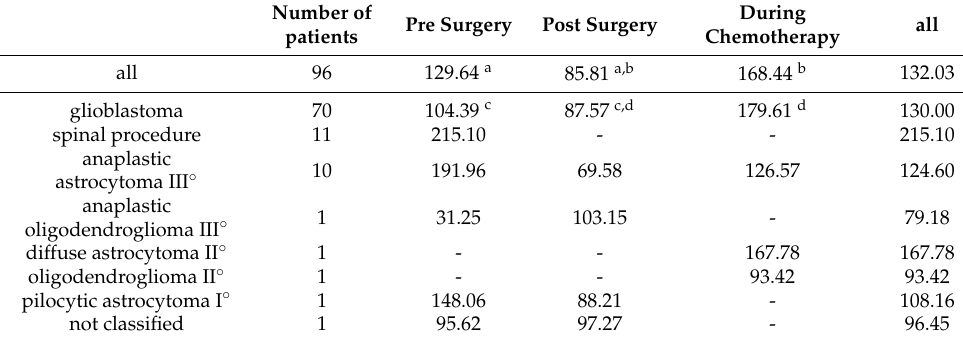
Table 2. Mean ApoC1 serum levels ( µ g/mL) in the diagnosis